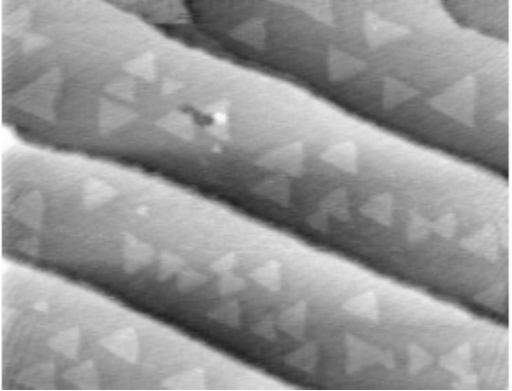
Figure 4. Scanning tunnelling microscopy (STM) image of triangular island formation during MBE growth in Ga rich conditions of (0001) GaN on SiC substrate [39]. Reprinted with permission from reference 39. Copyright (2006) by the American Physical